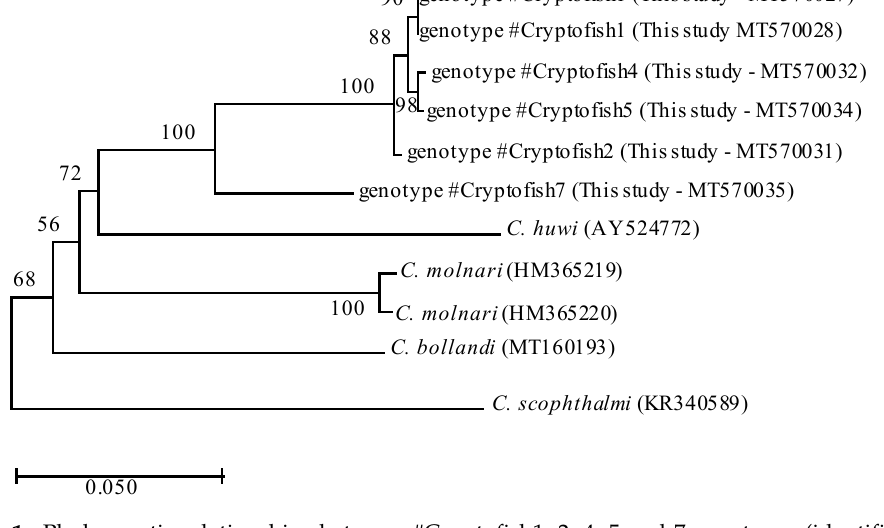
Figure 1. Phylogenetic relationships between #Cryptofish1, 2, 4, 5 and 7 genotypes (identified in the present study) and other piscine Cryptosporidium species inferred by ML analysis of actin gene. Percentage support ( > 50%) from 1000 pseudoreplicates from ML analyses is indicated at the left of the supported node. Scale bars indicate the number of substitutions per nucleotide position.